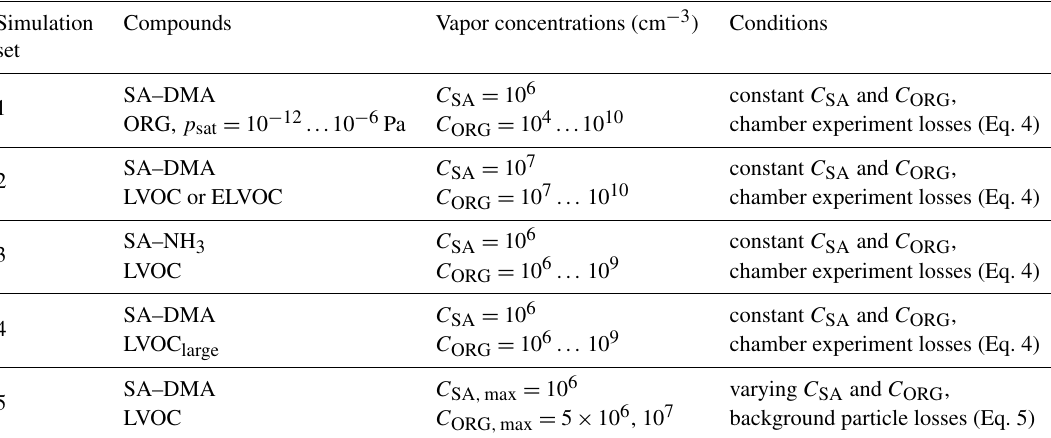
Table 3. Description of the simulation sets. The variables are varied at intervals of 1 order of magnitude. Note that the presented vapor concentrations are steady-state values for sets 1–4 and the maximum values for set